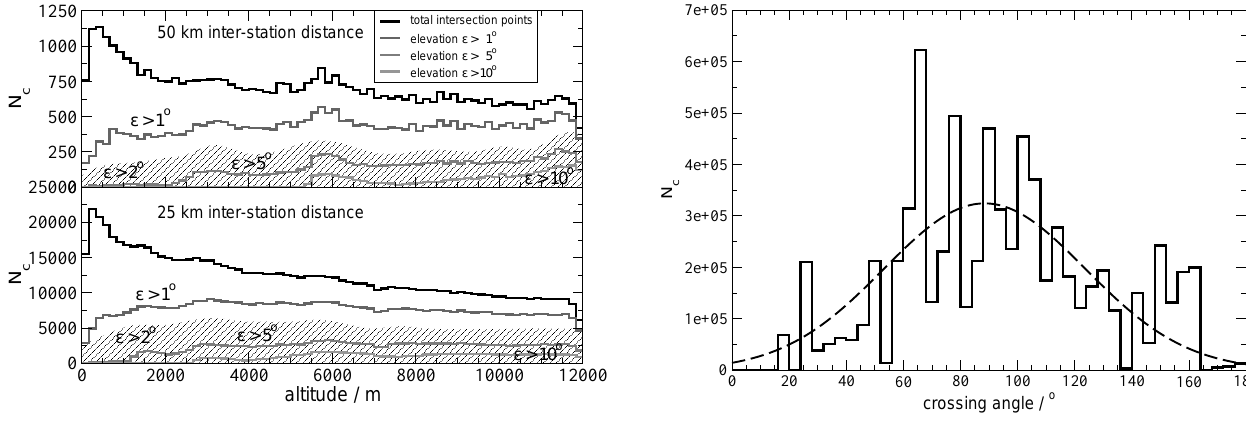
Fig. 8. Distribution of crossing angles between different intersect- ing ray paths for 15km inter-station distances and ε min = 0 ◦ . N c gives the number of intersection points within a 4 ◦ interval. A Gaus- sian fit has been applied to the data (dashed